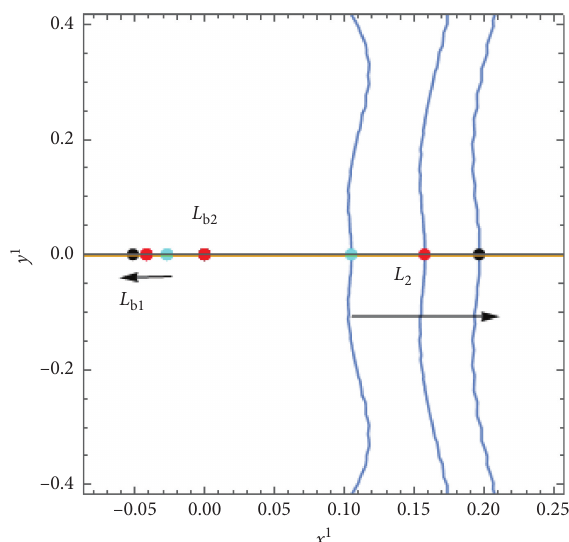
Figure 5: Zoomed part of Figure 4 near L